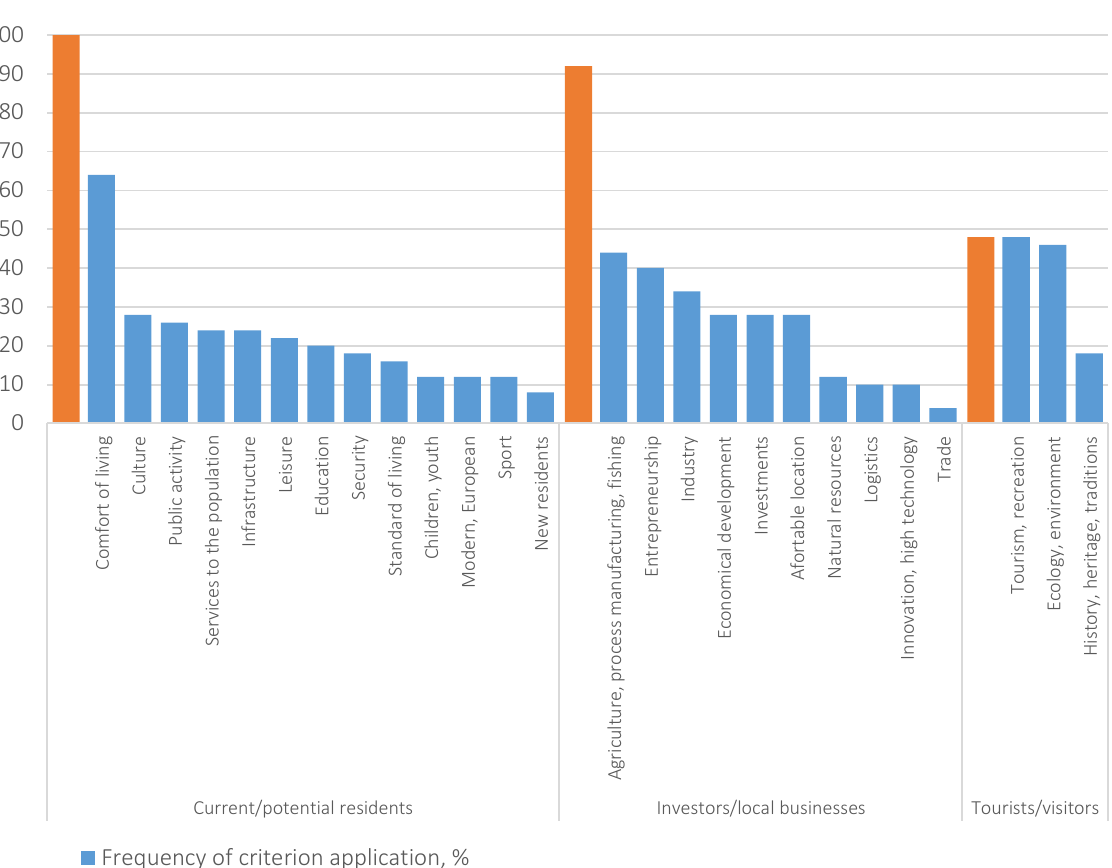
Figure 1. Percentage of communities that applied positioning criteria that targeted a specific